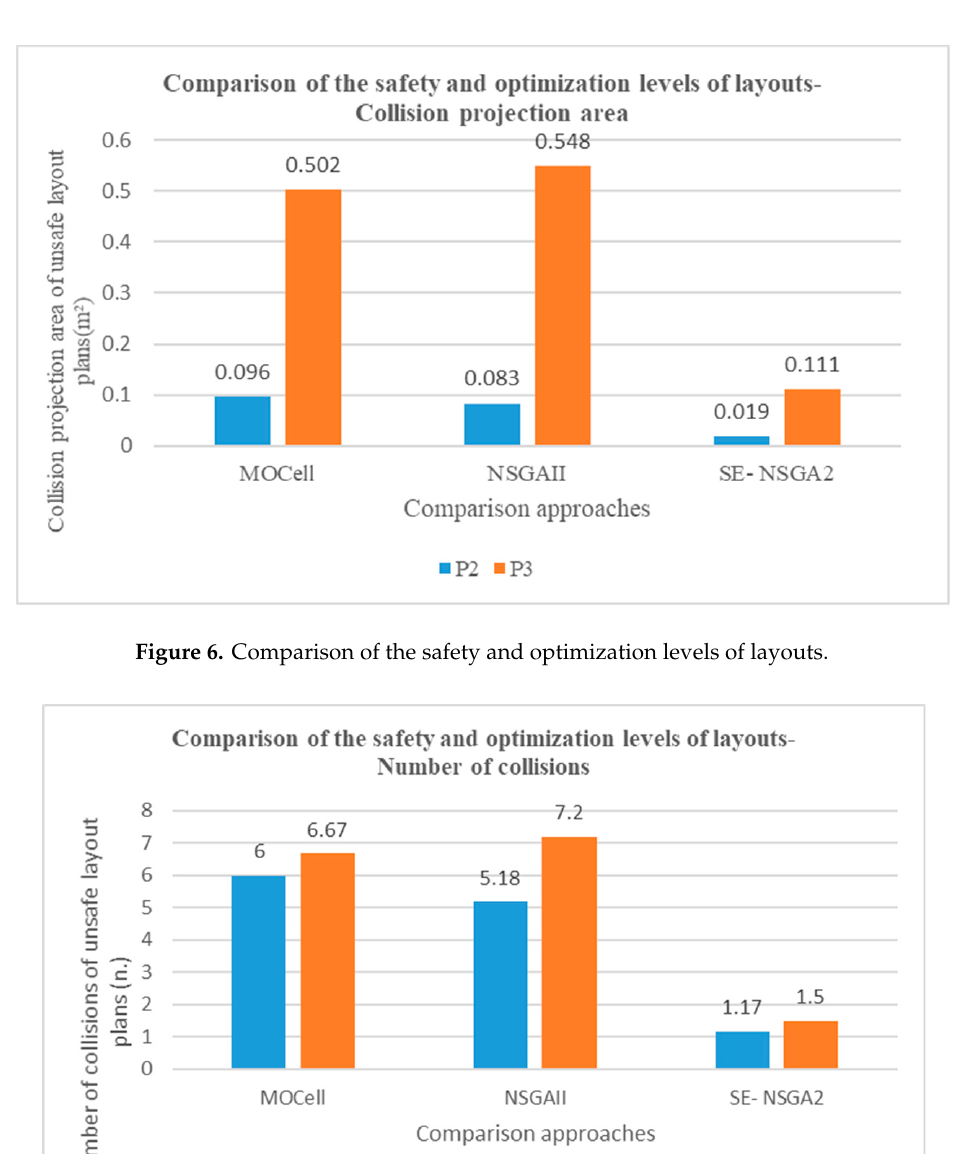
Figure 6. Comparison of the safety and optimization levels of layouts. Figure 7. Comparison of the number of collisions.